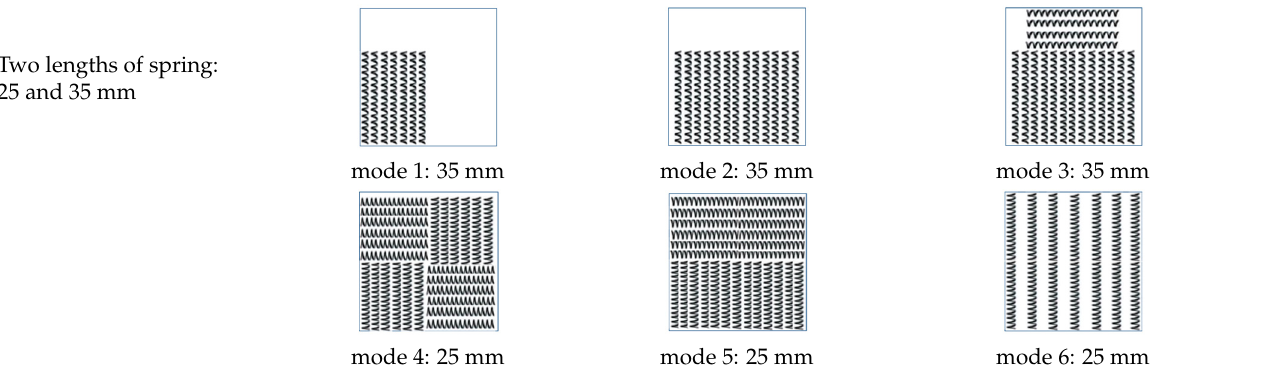
Figure 1. Experimental setting. ( a ) Front view and side view; ( b ) top view and front view.